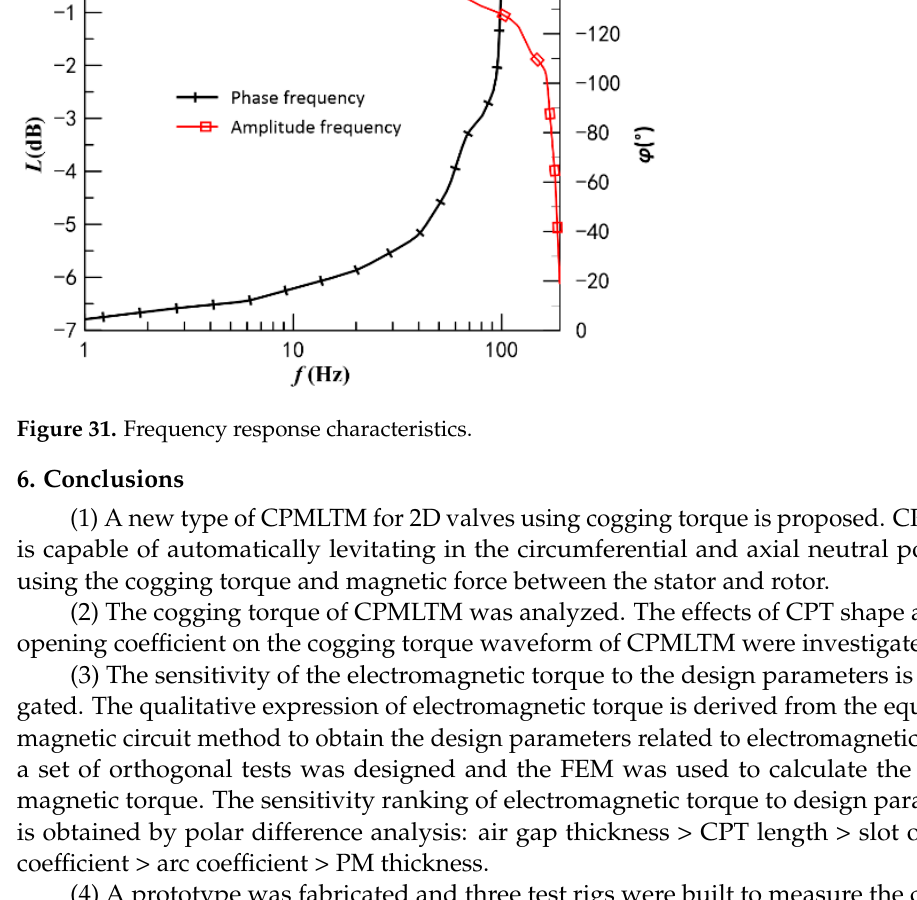
Figure 31. Sine wave following characteristics of CPMLTM. ( a ) 1 HZ, ( b ) 10 HA, ( c ) 40 Hz, ( d ) 80